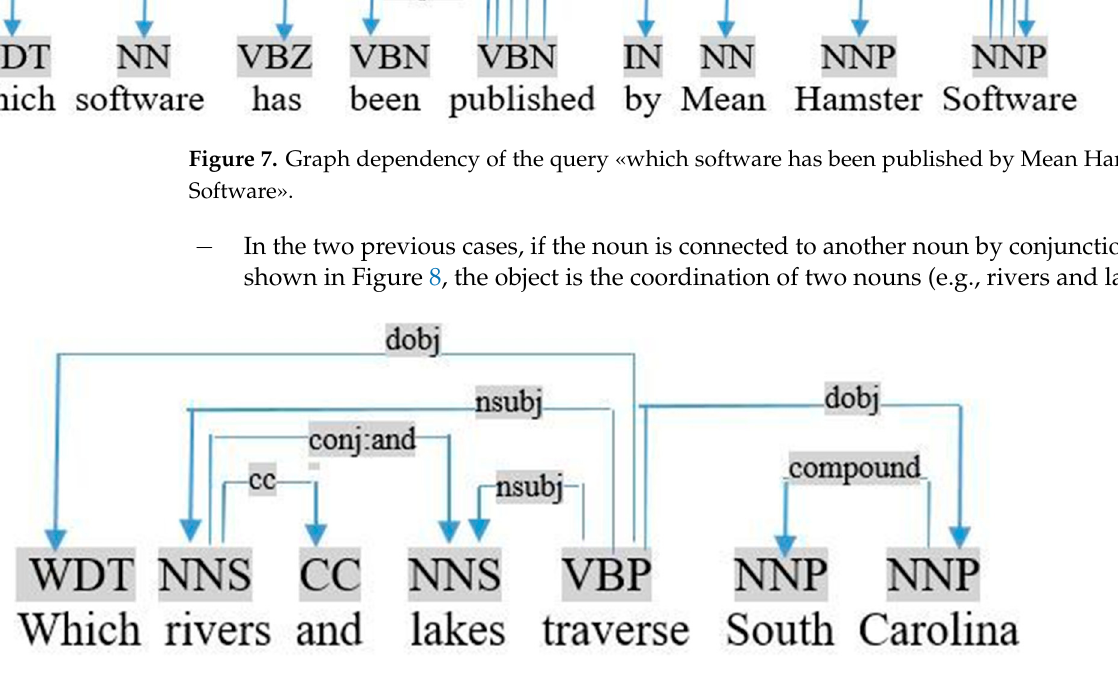
Figure 8. Graph dependency of the query «which rivers and lakes traverse South Carolina».